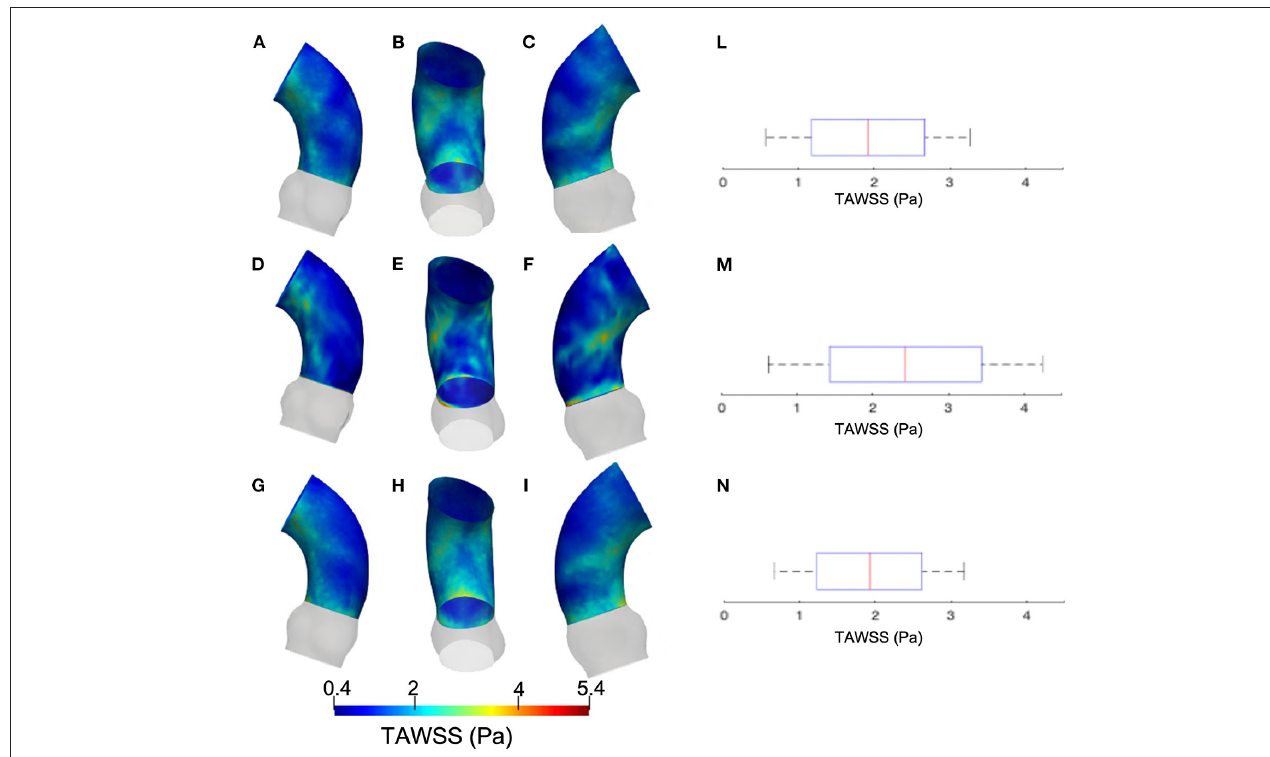
FIGURE 6 | Contour map of the time-averaged WSS (TAWSS) for geometry at phase p 0 considering three different level of smoothing: S L [min: 0.4 Pa, avg: 1.6 Pa, max: 2.3 Pa] (A–C) , S M [min: 0.4 Pa, avg: 2.0 Pa, max: 3.7 Pa] (D–F) and S H [min: 0.4 Pa, avg: 2.0 Pa, max: 3.7 Pa] (G–I) . Box plot of the TAWSS are reported for S L (L) , S M (M) , and S H (N) .